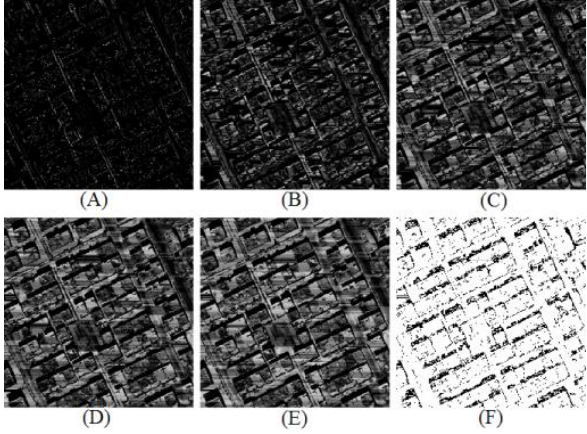
Figure 4. Subtraction of main image from reconstructed image by a SE with 180 degree direction and a scale of, A. 5×5, B.